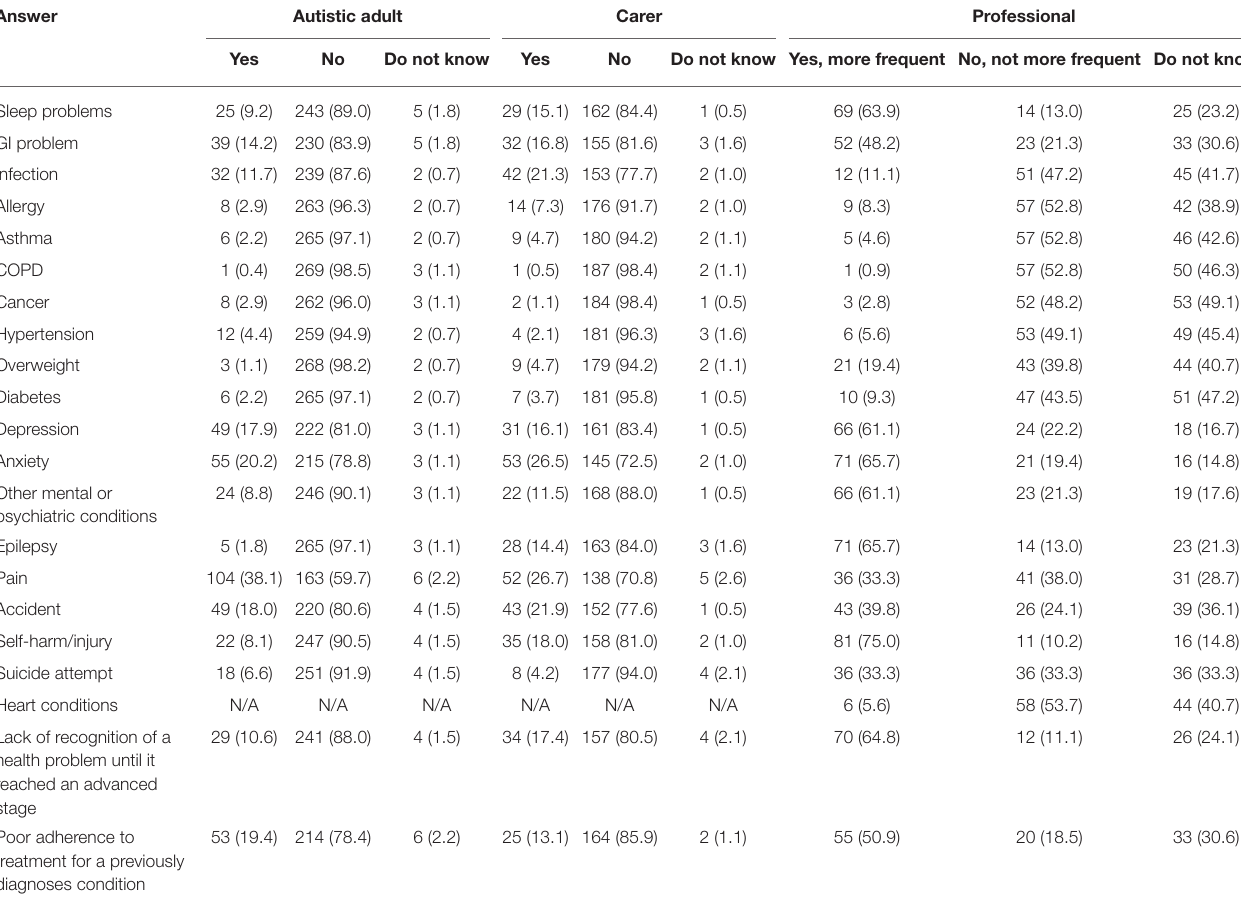
TABLE 2 | Reason for most recent hospital